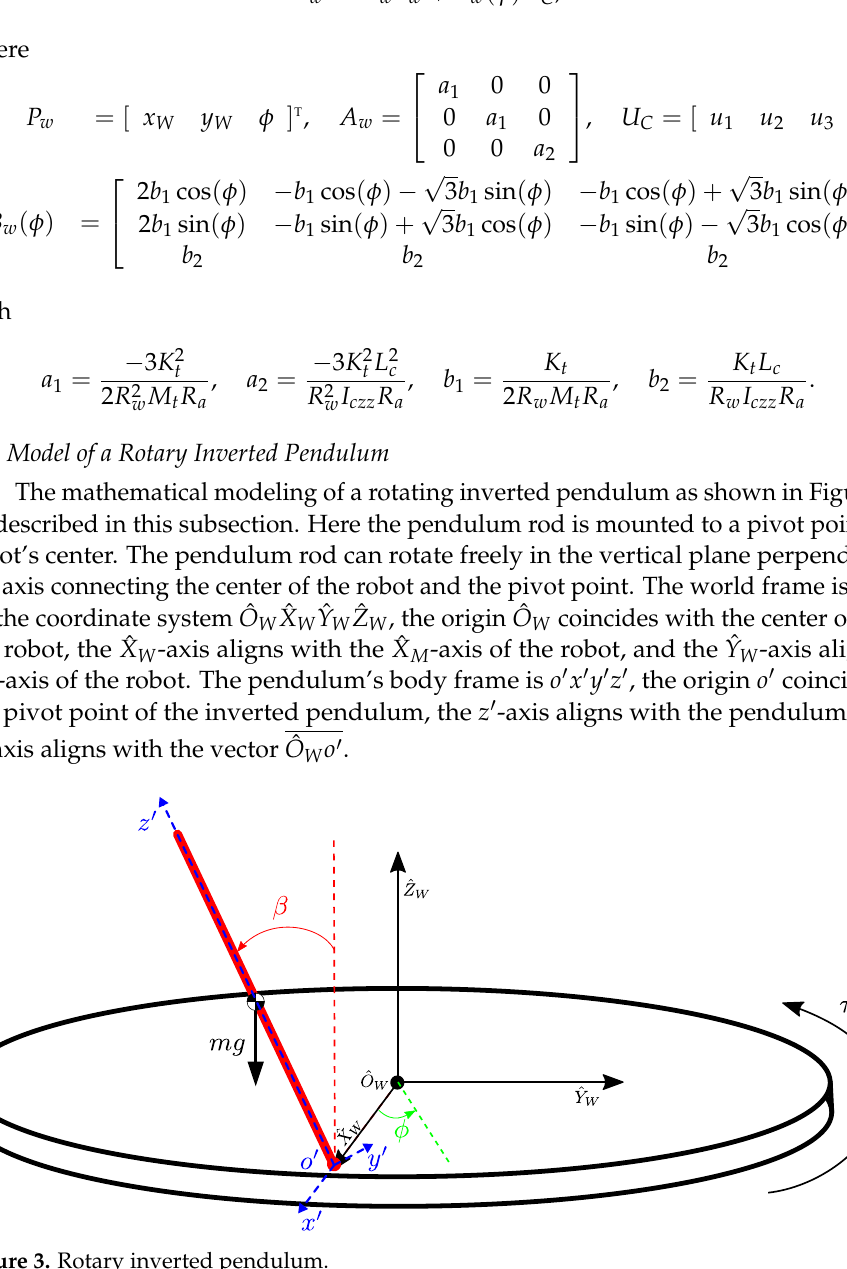
Figure 3. Rotary inverted